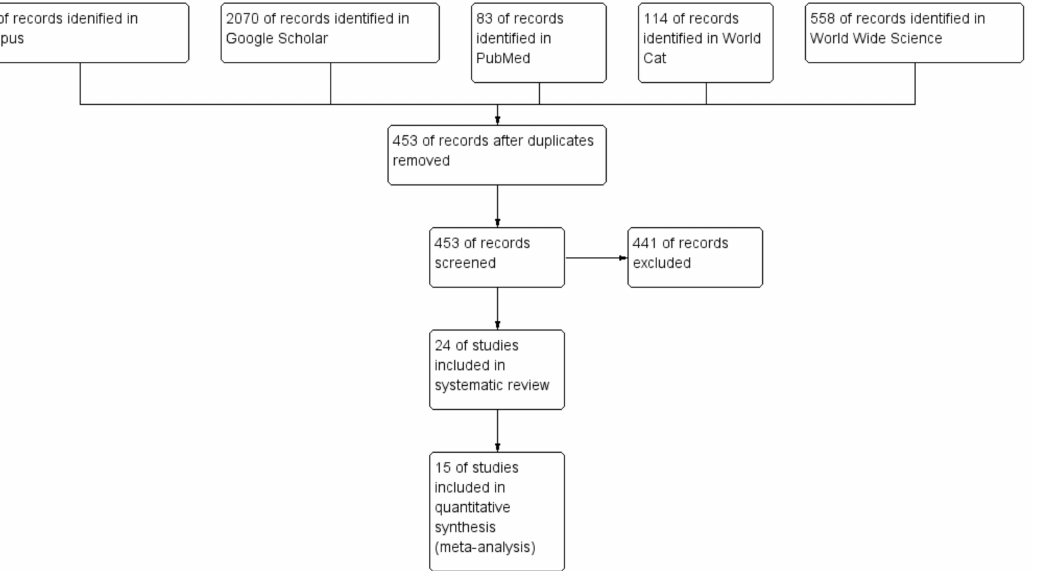
Figure 1. Flowchart for identification of published studies. Review Manager (RevMan